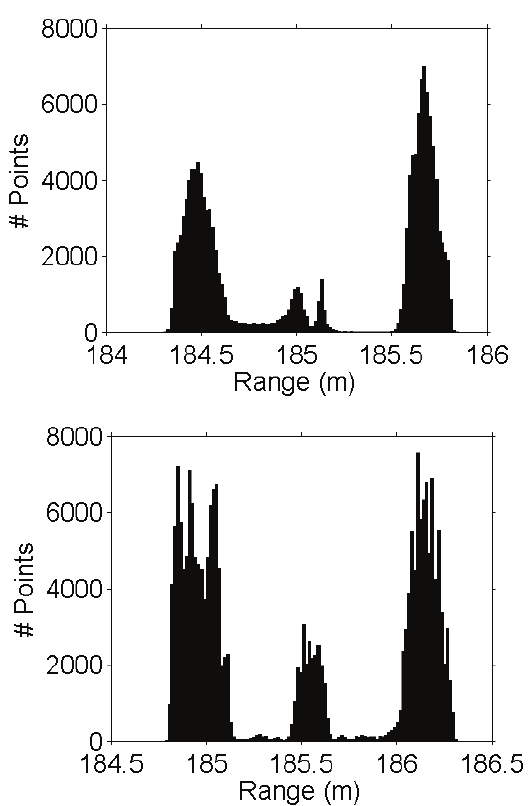
Figure 5: Range return histograms of Target 2 mesh, vertical sup- port, and backboard for (Top) VZ-400 and (Bottom) HRS-3D